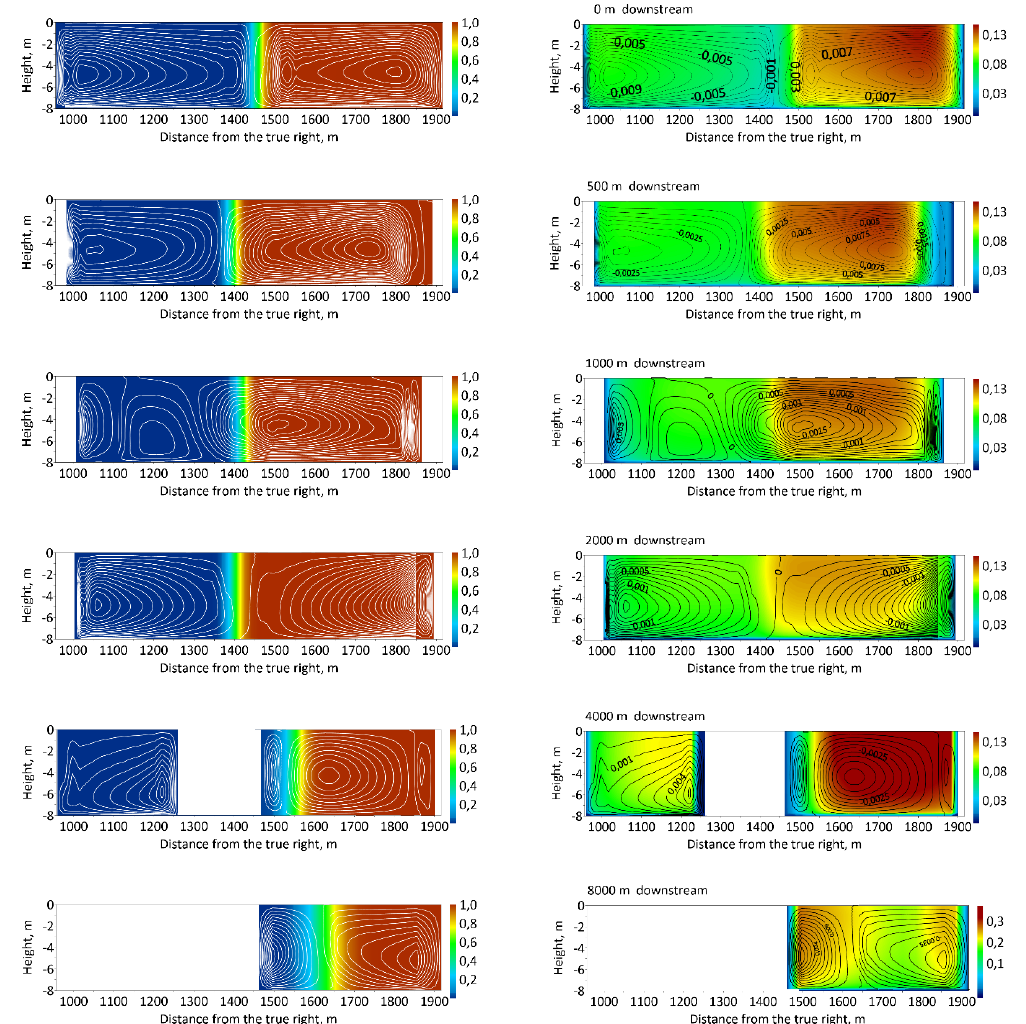
Figure 7. Predictions of concentration ( left ) and primary velocity ( right , m · s − 1 ) with the stream function for Q r = 0.62 and the P simulation geometry. Contours of flux are shown (units of m 2 · s − 1 ) as calculated by the stream function. Plots are viewed looking upstream, such that the Kama is on the left of each plot (i.e., the true right) and the Vishera on the right of each plot (i.e., true left). The contour values are only shown on the primary velocity plots.